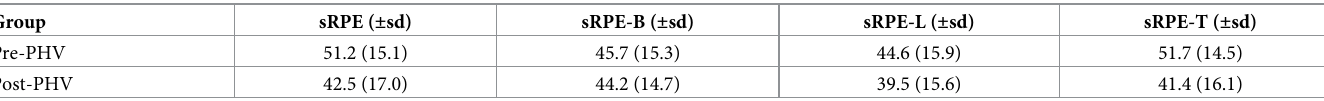
Table 1. Means and standard deviations of dRPE values across groups.